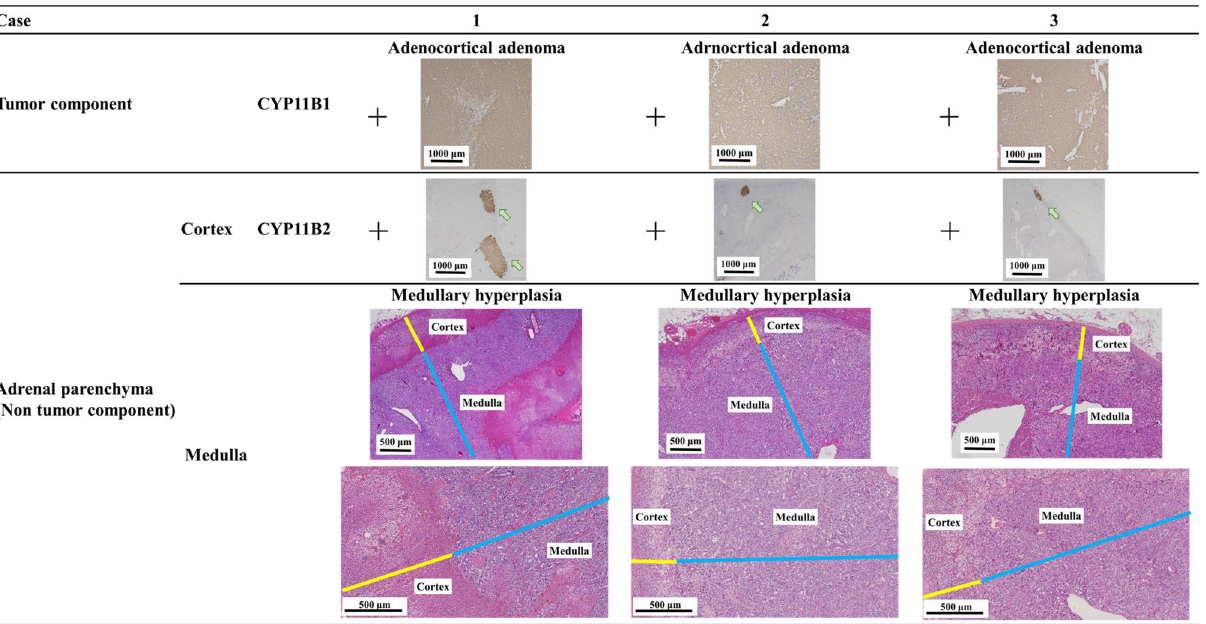
Figure 2. All the adrenal tumors were cortical adenomas and CYP11B1 positive images were observed. CYP11B2 were locally positive in the non-tumor part (arrows). Background adrenal parenchyma showed adrenal medullary hyperplasia in all 3 cases.